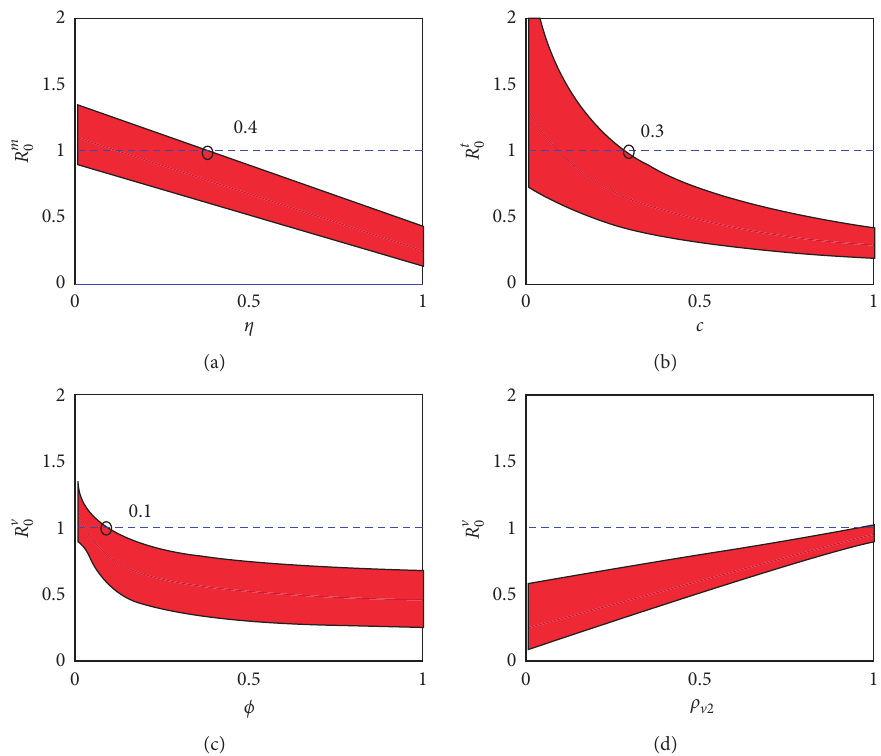
Figure 6: Dynamics of control reproduction number versus key factors. All parameters are varied uniformly within 20% of its value in Table 1 except σ � 0. Red region denotes the area where the 1000 simulation realizations lie. (a) R m culling proportion c . (c) R v versus coverage of vaccination ϕ . (d) R v 0